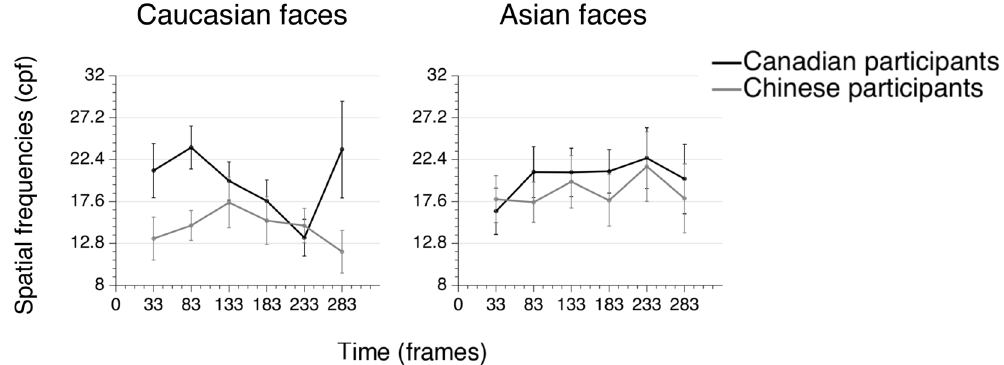
Figure 3. Canadian and Chinese observers’ SF tuning peaks (group average), for Western Caucasian and East Asian faces